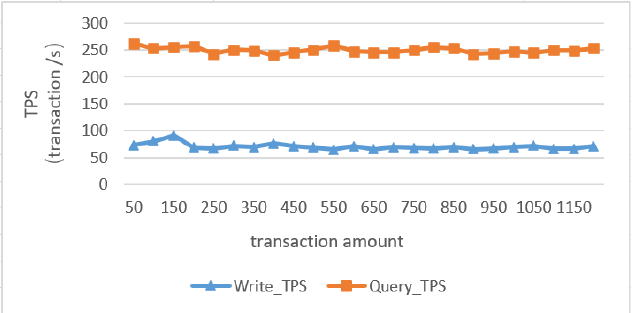
Figure 9. Network throughput testing of blockchain channel.